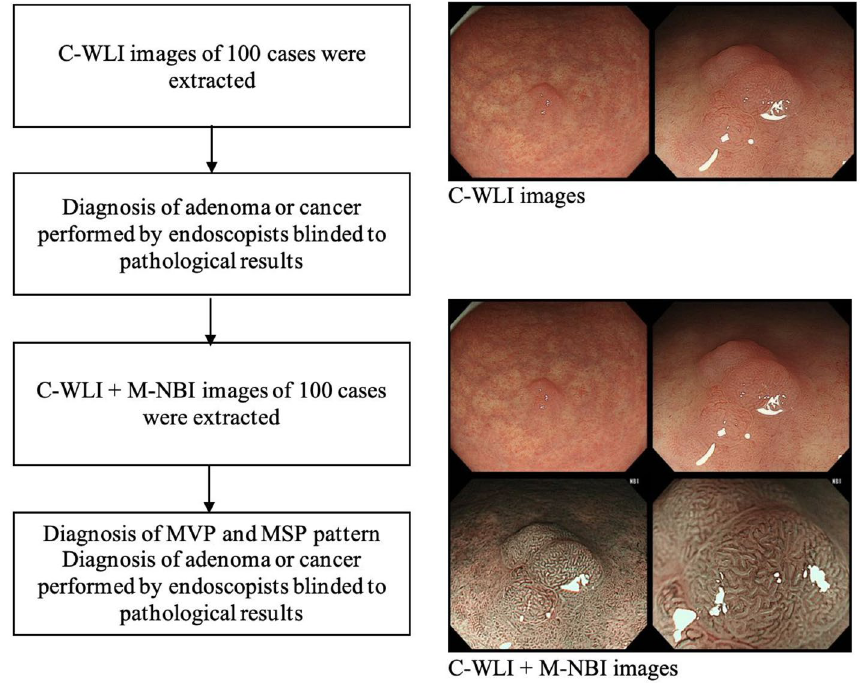
Figure 4. Flow chart of endoscopic